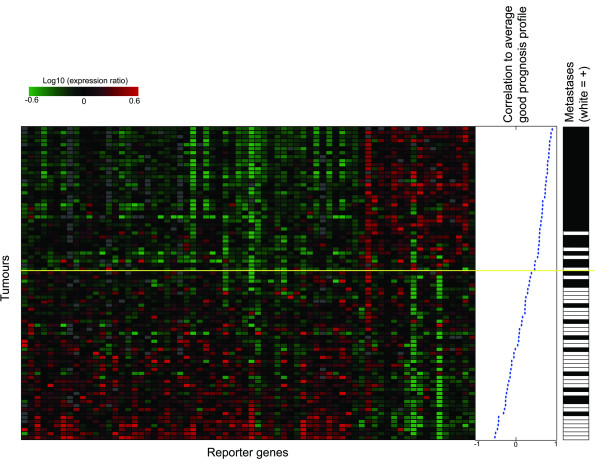
Expression data matrix of 70 prognostic markers genes from tumors of 78 breast cancer patients hybridized using the custom microarray. Each row represents a tumor and each column a gene. Genes are ordered according to their original ordering. Tumors are ordered by their correlation to the average profile of the good prognosis group (middle panel). The metastases status for each patient is shown in the right panel. White indicates patients who developed metastases within 5 years after the initial diagnosis, black indicates patients who continued to be metastasis free for at least 5 years.